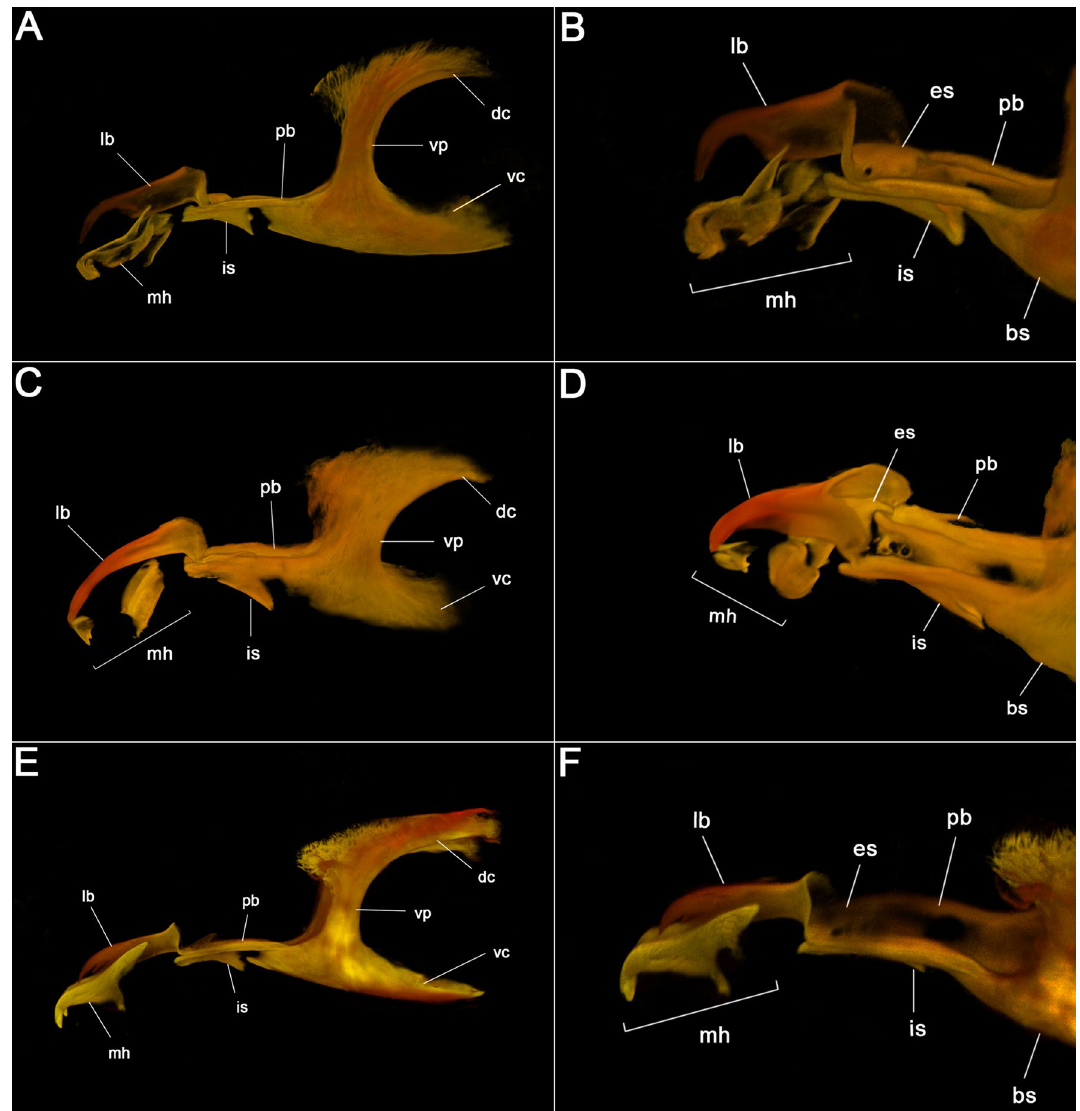
Figure 6. CLSM images of first instar larva of Australian Miltogramminae ( A ) Aenigmetopia amissa , cephaloskeleton, lateral view. ( B ) Aenigmetopia amissa , anterior part of cephaloskeleton, postero-lateral view. ( C ) Amobia auriceps , cephaloskeleton, lateral view. ( D ) Amobia auriceps , anterior part of cephaloskeleton, postero-lateral view. ( E ) Protomiltogramma cincta , cephaloskeleton, lateral view. ( F ) Protomiltogramma cincta , habitus, anterior part of cephaloskeleton, postero-lateral view. dc, dorsal cornua; es, epistomal sclerite; is, intermediate sclerite; lb, labrum; mh, mouthhook; pb, parastomal bar; vc, ventral cornua; vp, vertical